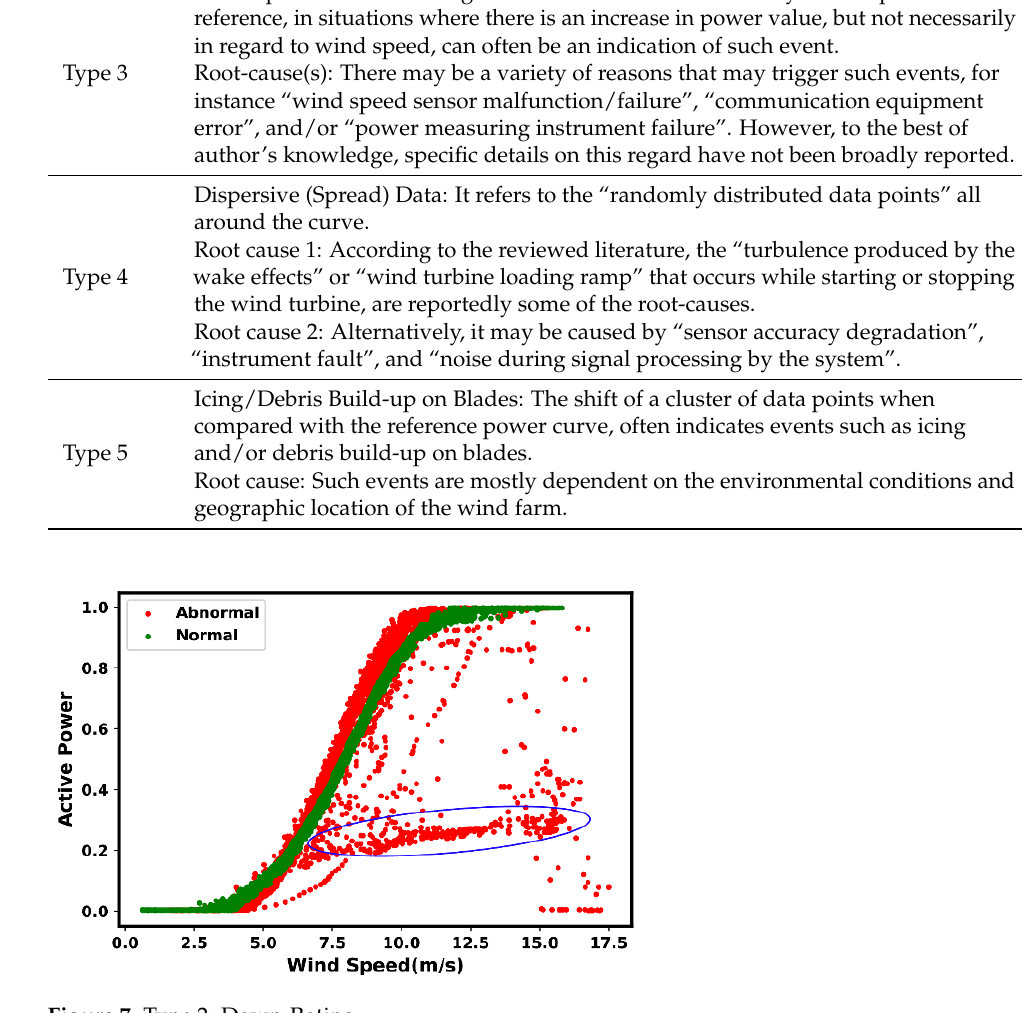
Figure 8. Type 3: Wind Speed Under-Reading.